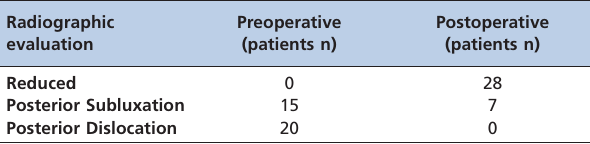
Table 3 - Pre- and postoperative radiographic evaluations.